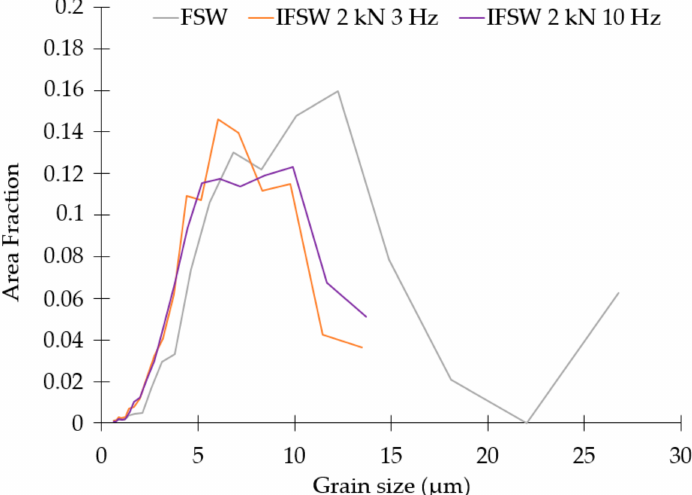
Figure 4. Grain size distributions of the produced FSW and IFSW welds.